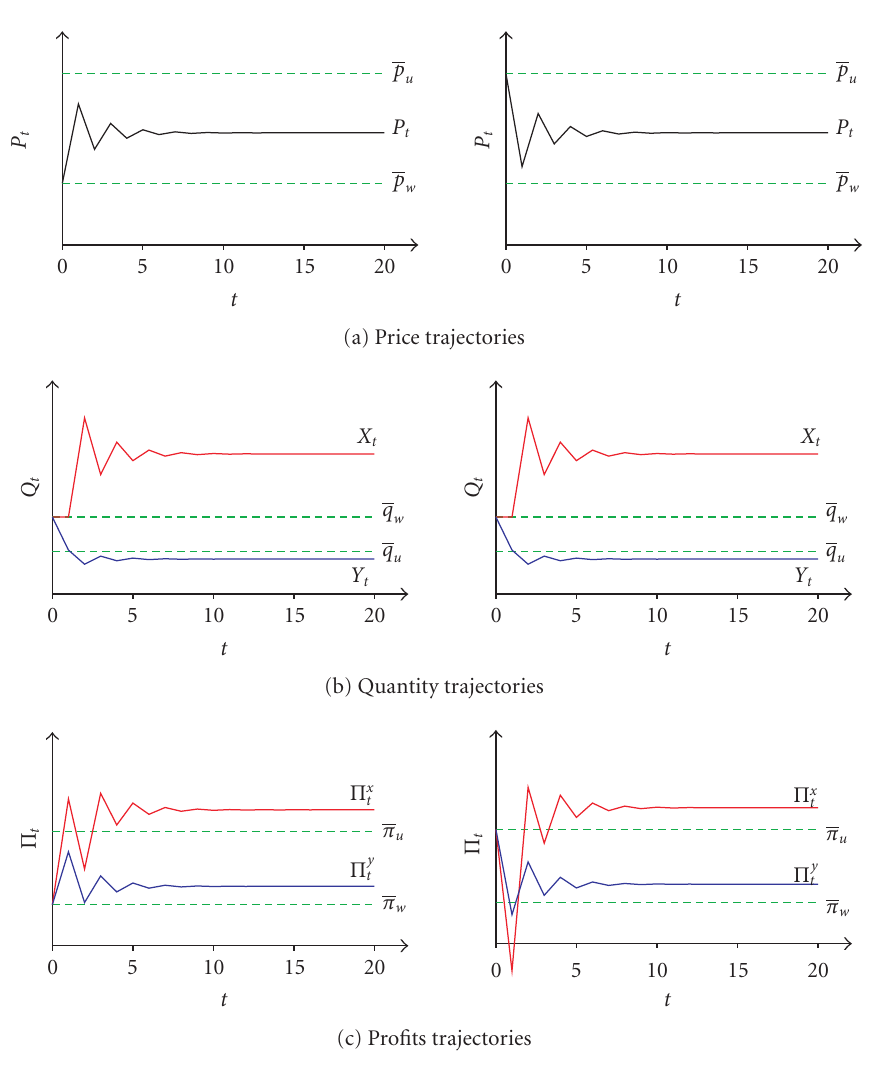
Figure 4.5. Convergency to the equilibrium, m = 3, σ =